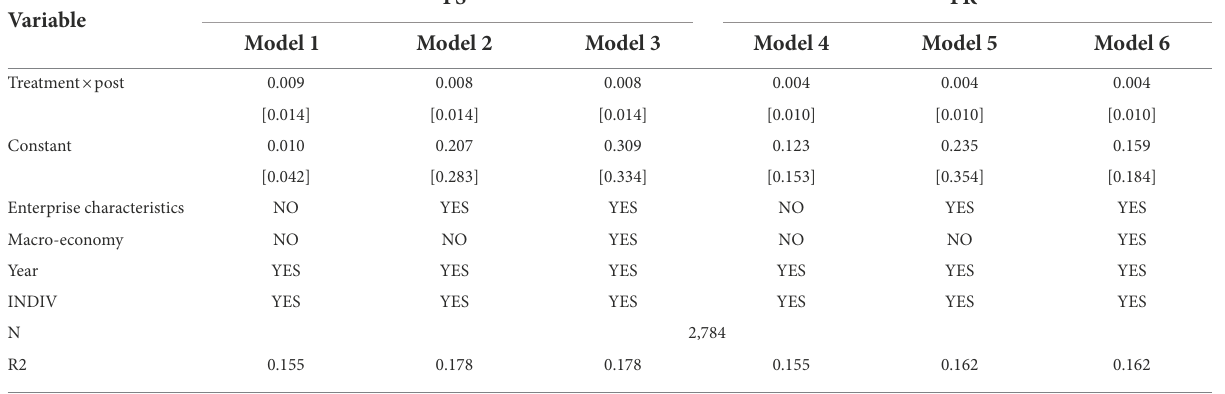
TABLE 5 Results of placebo effect test.